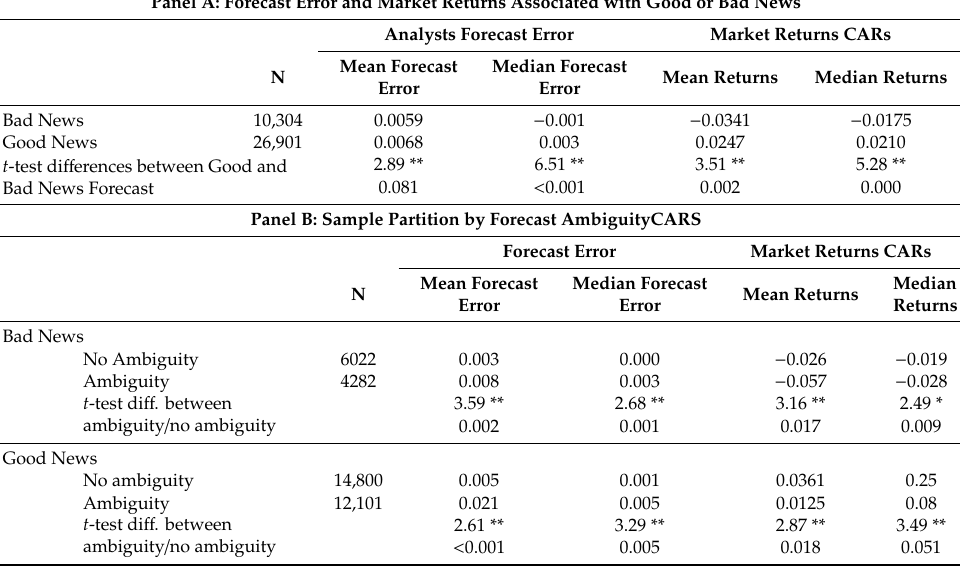
Table 2. Summary statistics of accumulative stock returns and various firm characteristics. Panel A: Forecast Error and Market Returns Associated with Good or Bad